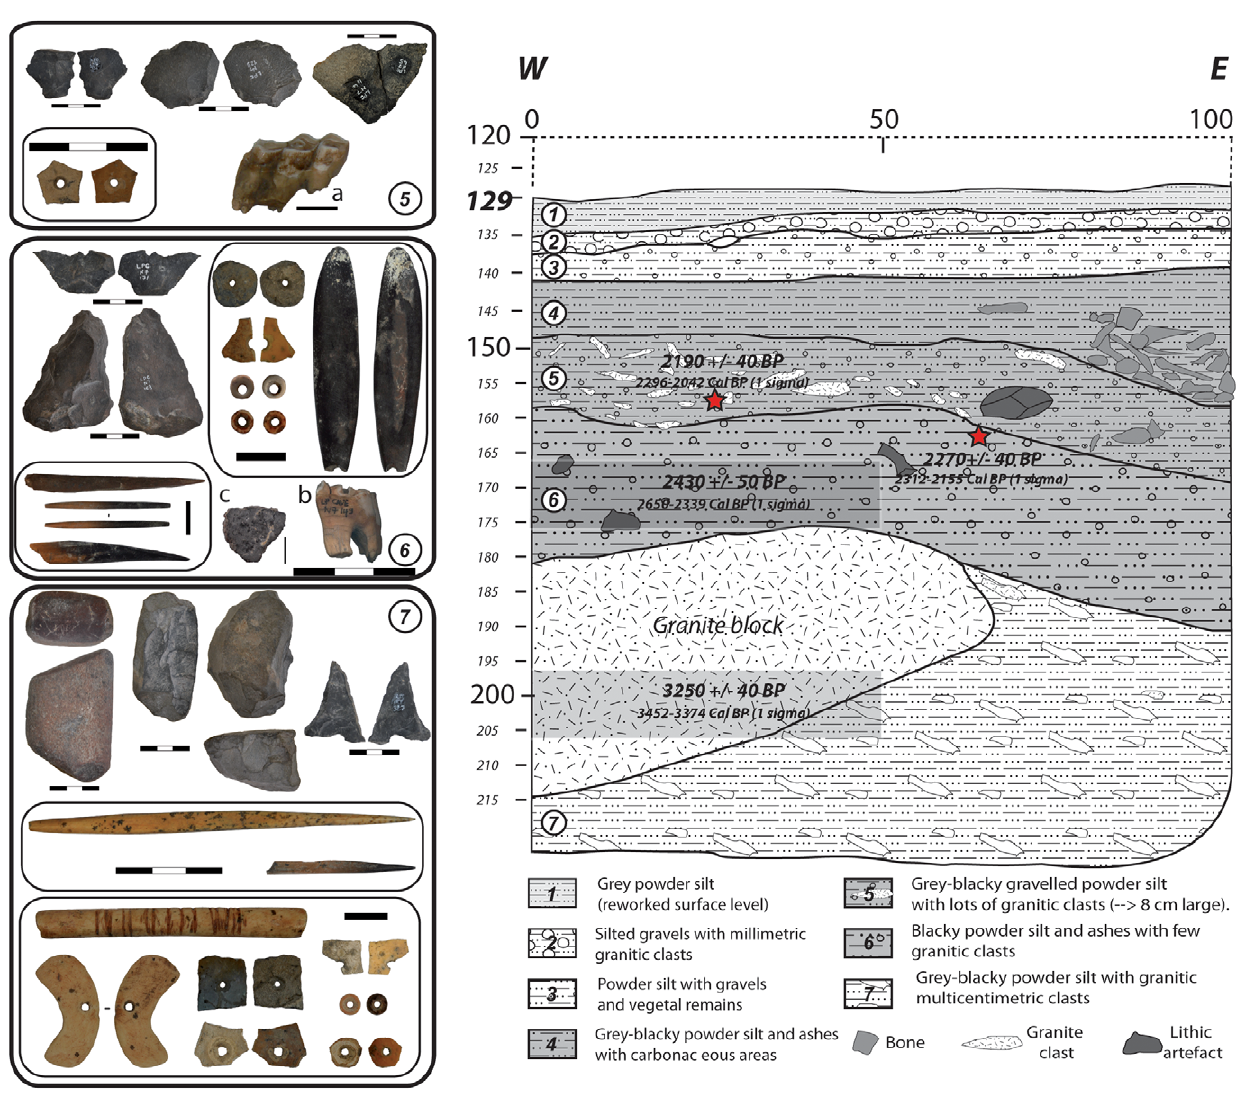
Figure 2. Synthetic stratigraphic section E-W (transversal) of 7/8 band of Leopard Cave (in cm), with location of the dated samples. Examples of archaeological remains found in Layers 5, 6 and 7.